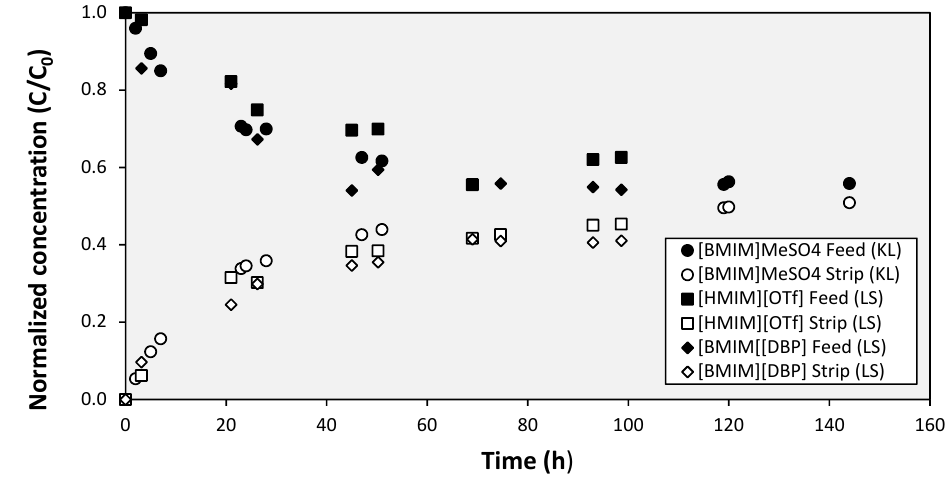
Figure 9. Evolution of the concentration of Kraft lignin (KL) or lignosulphonate (LS) in the feed and stripping compartments with three different SILMs supported in PCTE.